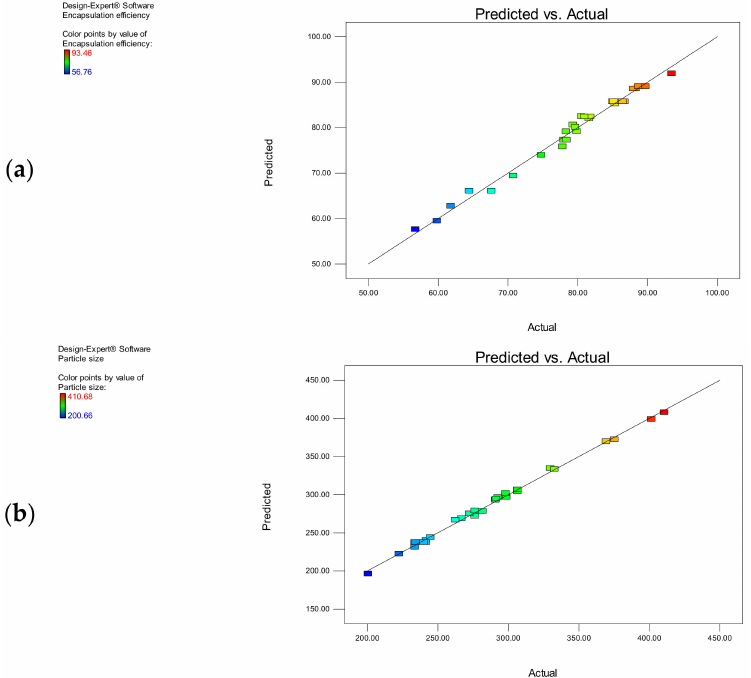
Figure 1. Comparison between predicted and actual values for ( a ) encapsulation efficiency and ( b ) particle